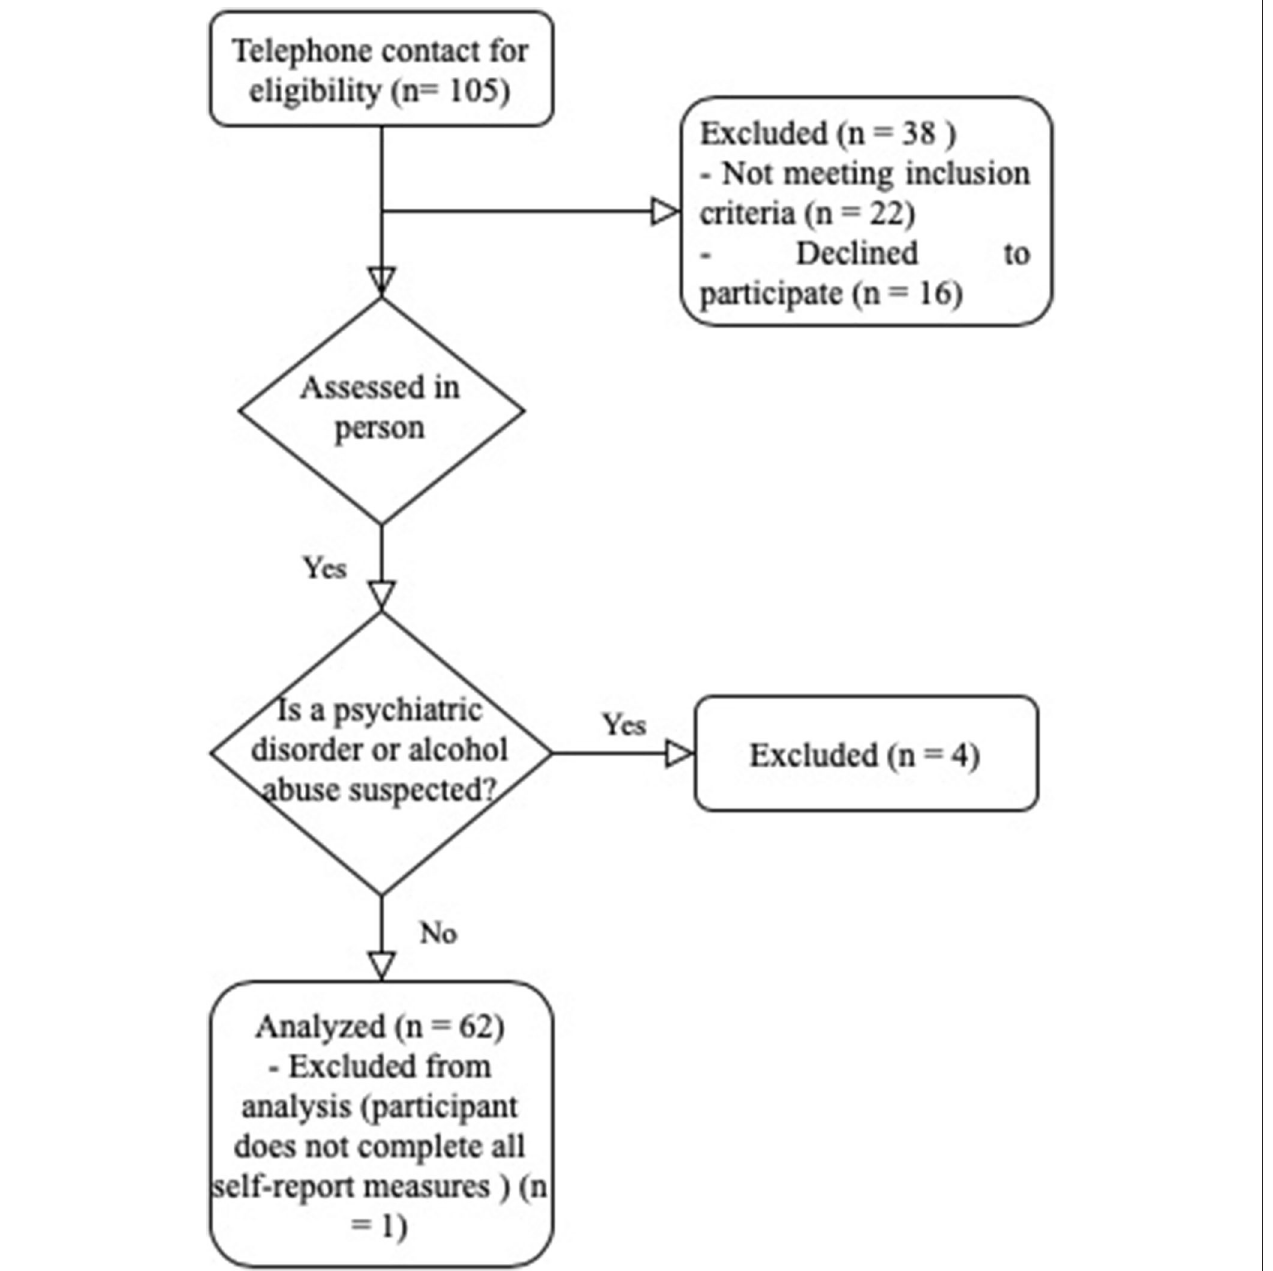
FIGURE 1 | Study design